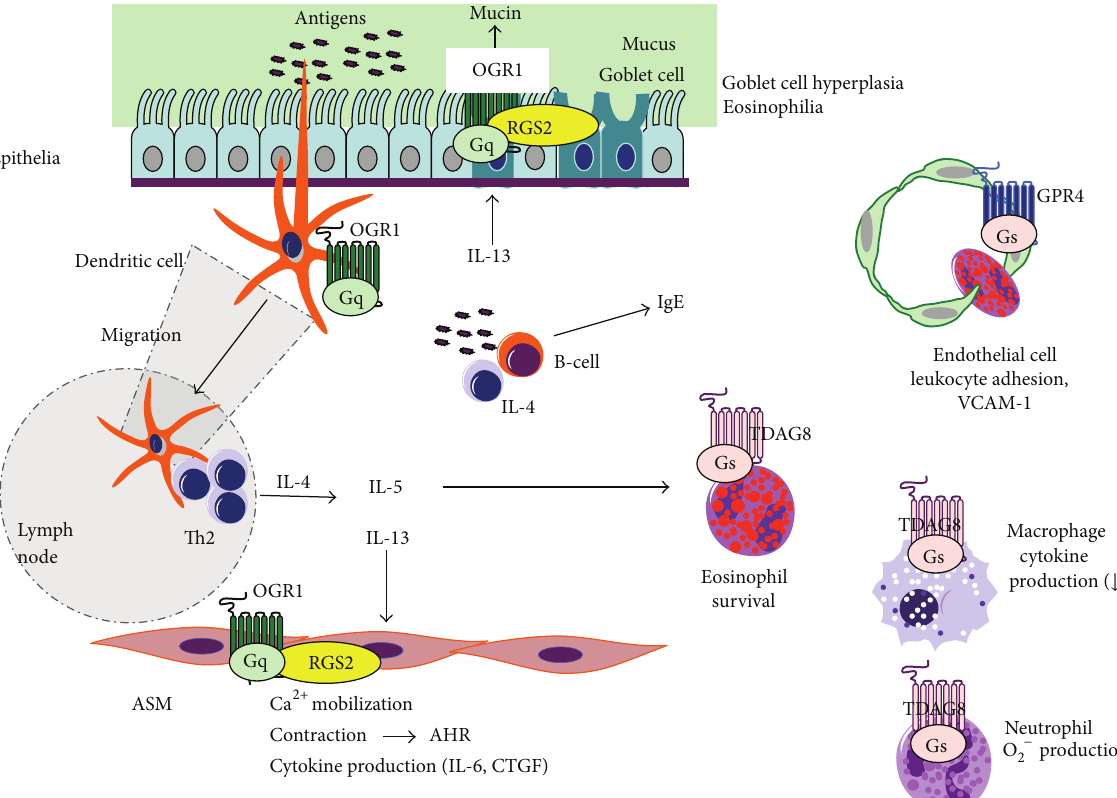
Figure 2: Role of OGR1-family GPCRs in Th2 polarization and subsequent airway inflammation and AHR. See the text in